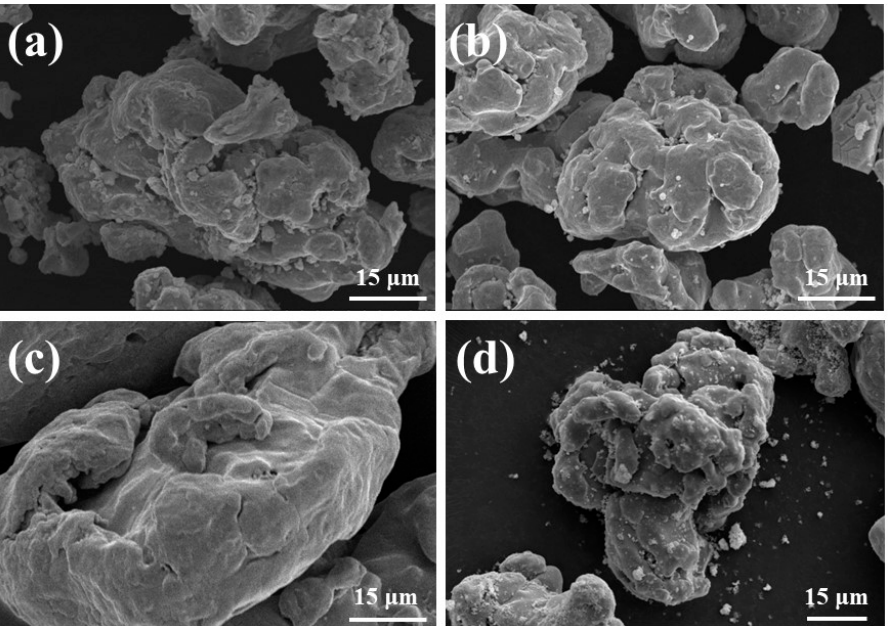
Figure 2. SEM of photolytically coated iron powder with different treatments: ( a ) Zn(C 2 H 5 ) 2 , ( b ) Zn(C 2 H 5 ) 2 + C 6 H 14 , ( c ) 5 wt.% KH550, and ( d ) 5 wt.% KH550 and (Zn(C 2 H 5 ) 2 + C 6 H 14 ).